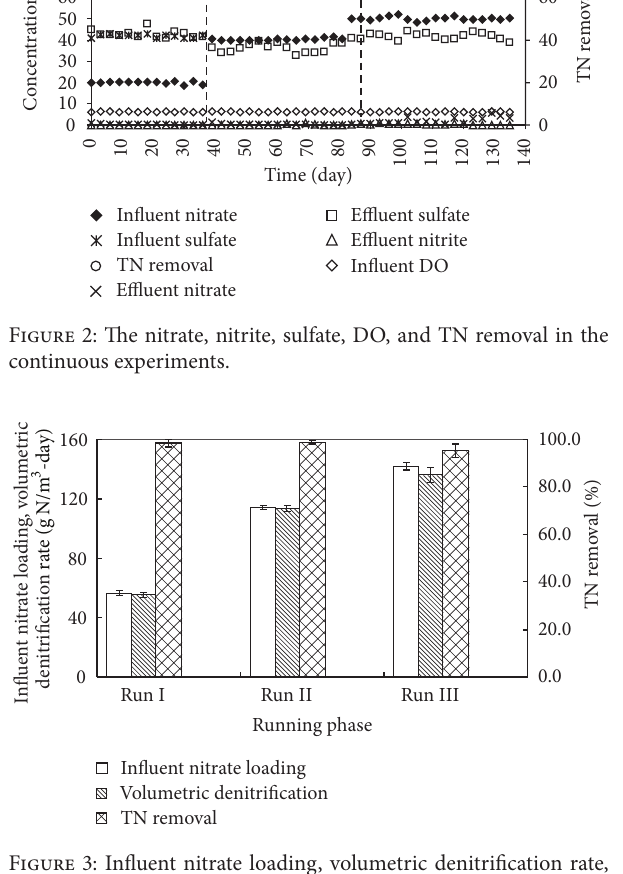
Figure 3: Influent nitrate loading, volumetric denitrification rate, and TN removal in the experiment. Error bars represent the standarddeviationbetweencontinuoussamplesduringonerunning